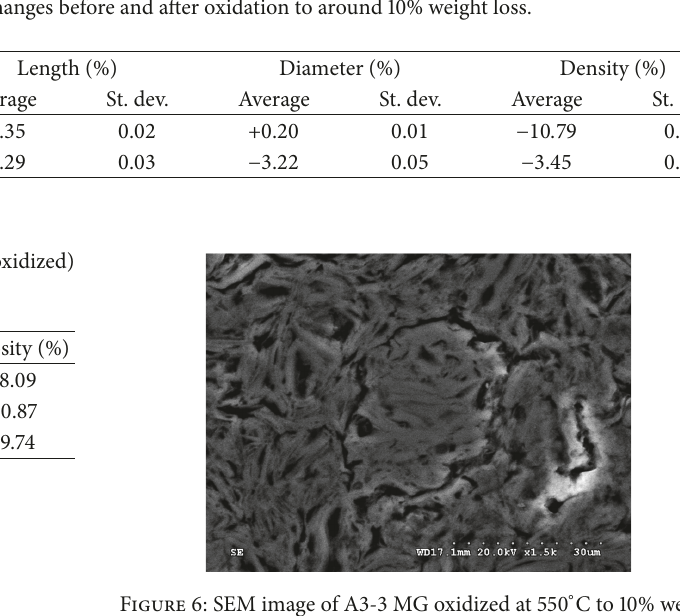
Table 2: Average physical property changes before and after oxidation to around 10% weight loss.